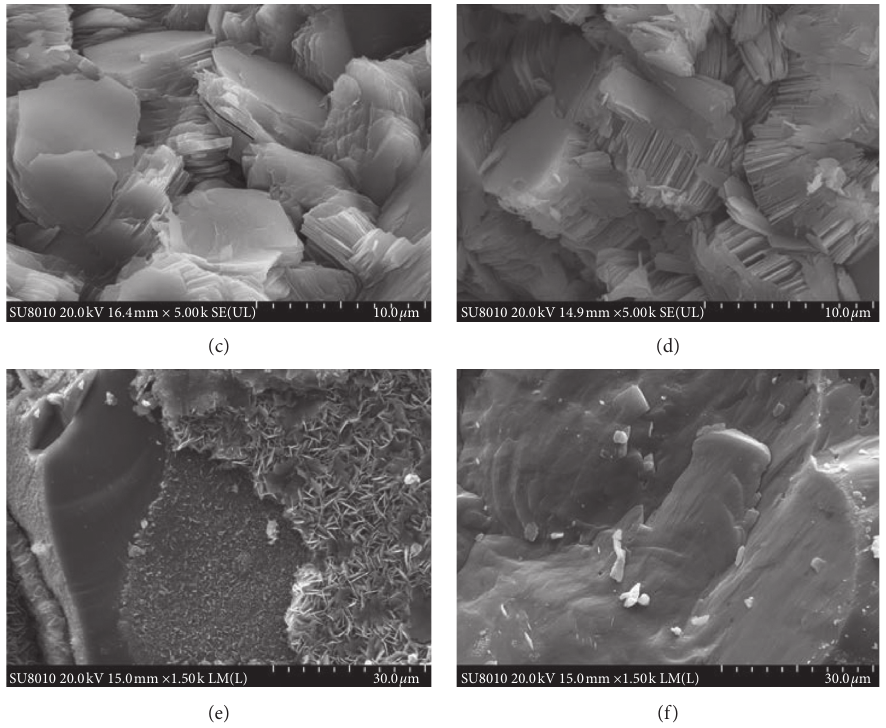
Figure 12: SEM images of fracture: (a, c, e) room temperature; (b, d, f) after treatment at 600 ° C.